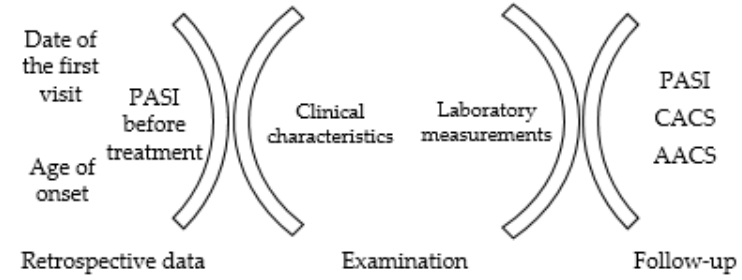
Figure 2. The progress of research sample collection.